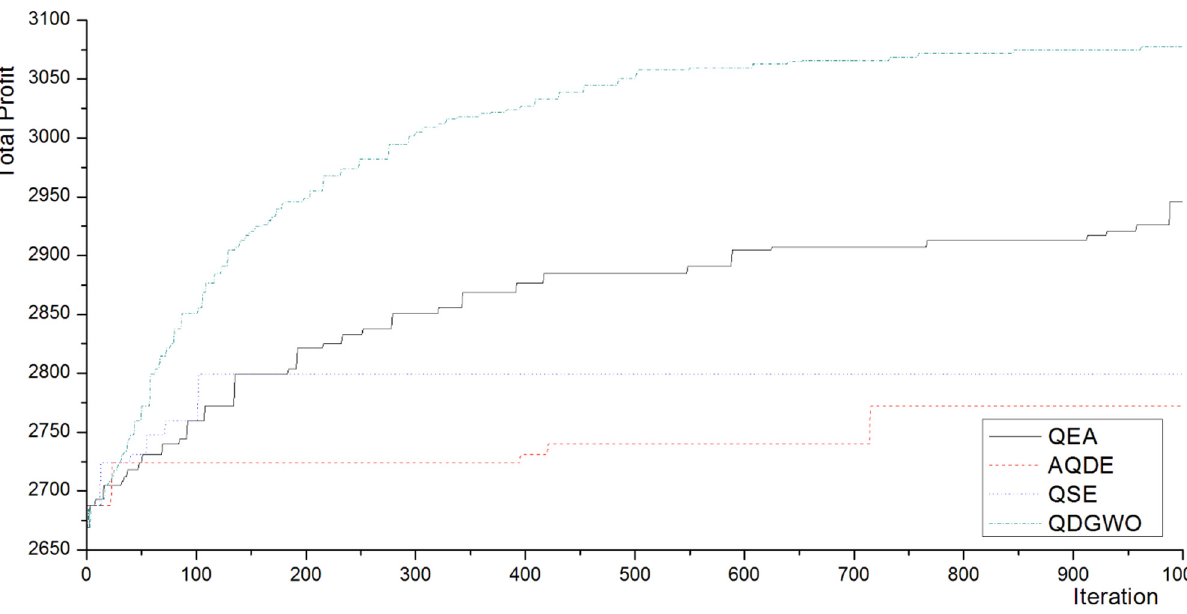
Figure 6. Best profits for the 0-1 knapsack problems (1000 items in Experiment 1).